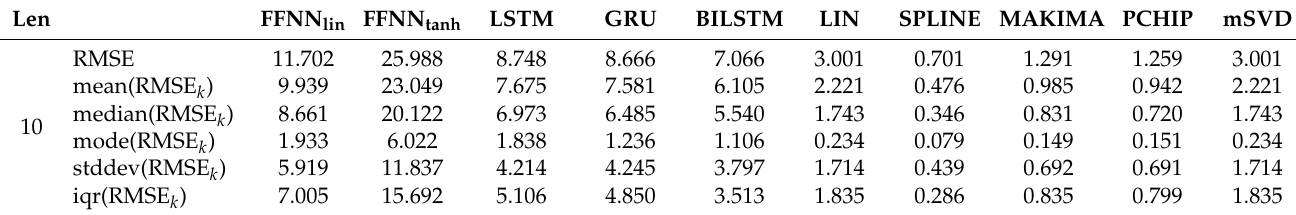
Table A2. Quality measures for the running (No. 3)